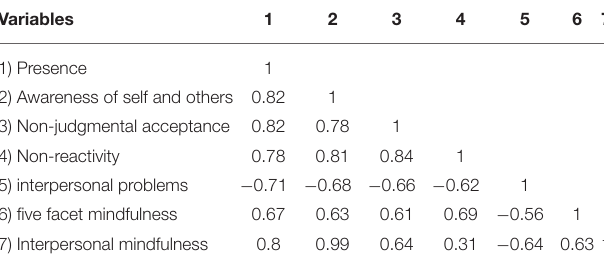
TABLE 4 | Correlations between the studied variables.